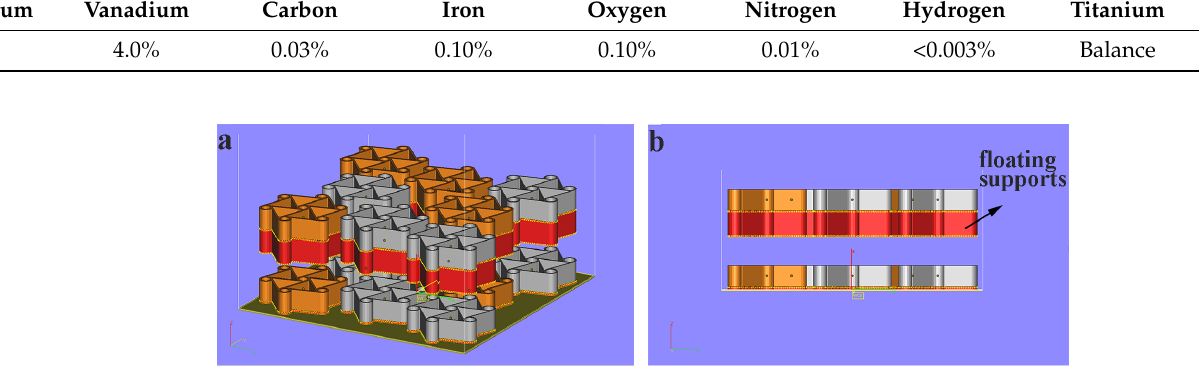
Figure 2. Floating parts production in EBM: ( a ) iso view and ( b ) front view.